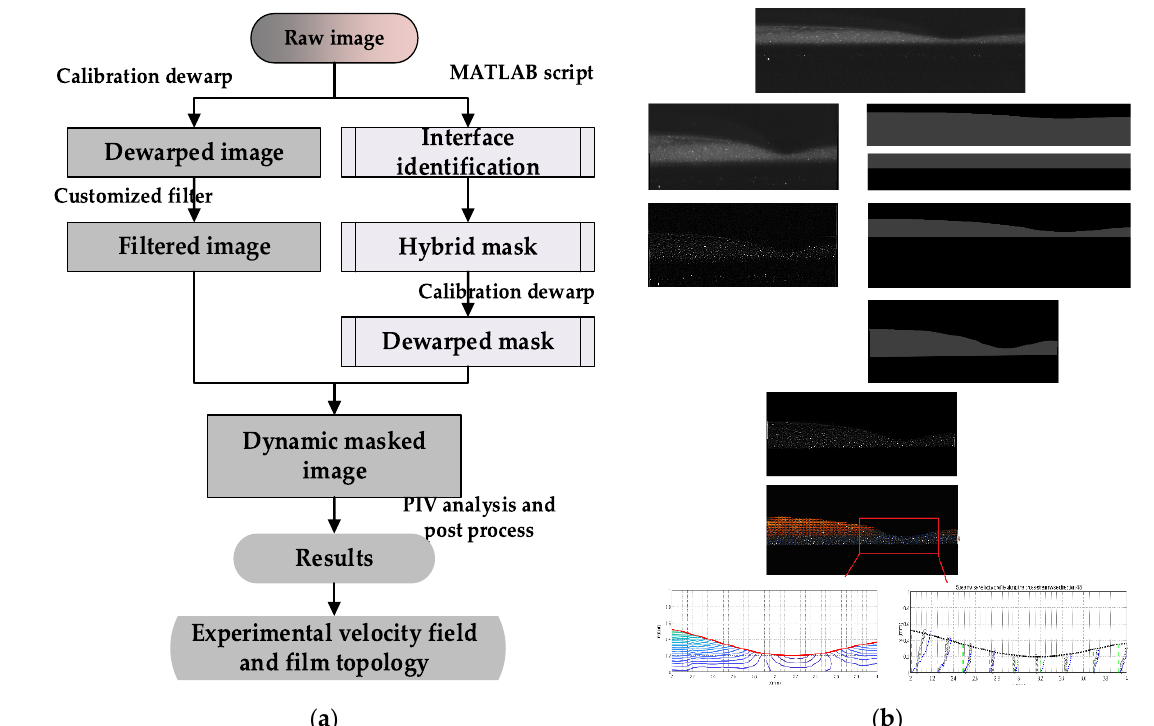
Figure 4. Schematic illustration of PIV/PLIF process. ( a ) PIV/PLIF process. ( b ) PIV/PLIF process example. Each of the procedures in ( a ) corresponds to an image outcome in ( b ) in the order of top to bottom, and then left to right [19].